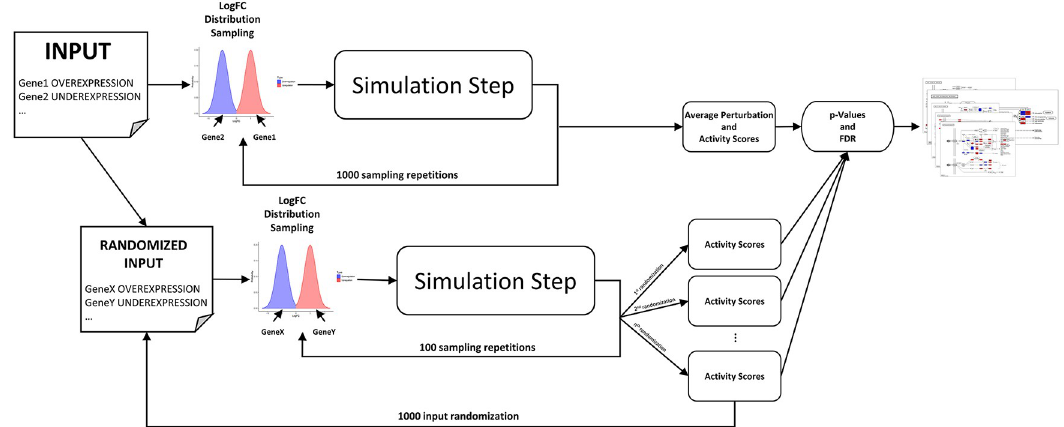
Fig 6. Description of the PHENSIM algorithm. First, the user provides a set of genes and the type of alteration (over-/under- expression). Then, synthetic LogFCs are generated, and a simulation step is performed. This procedure is repeated 1000 times to compute the Activity Scores . Next, user input is randomized, and 100 synthetic LogFC are generated to estimate Activity Scores using the simulation step. This input randomization is repeated 1000 times for greater precision. Finally, p-values are computed, and the False Discovery Rate is estimated using the q-value